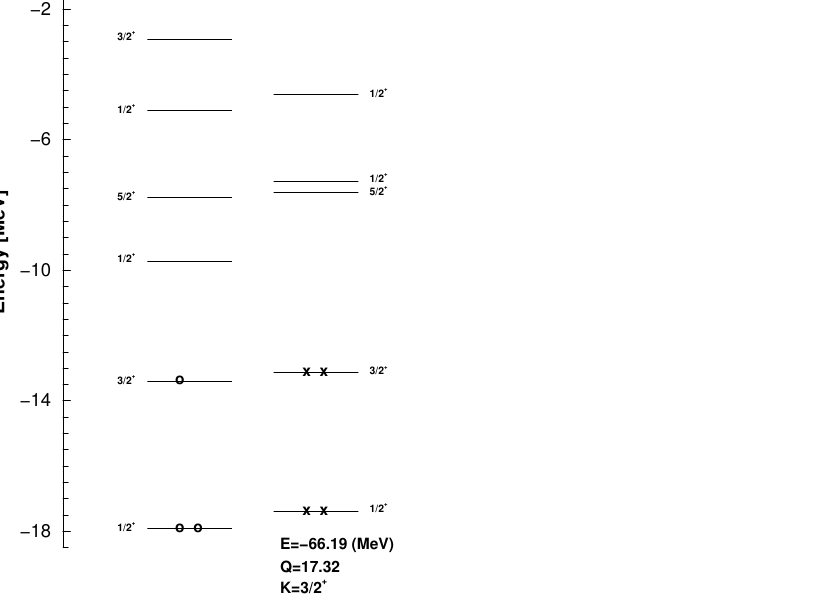
Figure 3. HF single-particle spectra for 23 Na corresponding to lowest configuration. In the figure, circles represent protons and crosses represent neutrons. The HF energy E in MeV, mass quadrupole moment Q in units of the square of the oscillator length parameter and the total azimuthal quantum number K are given in the figure.